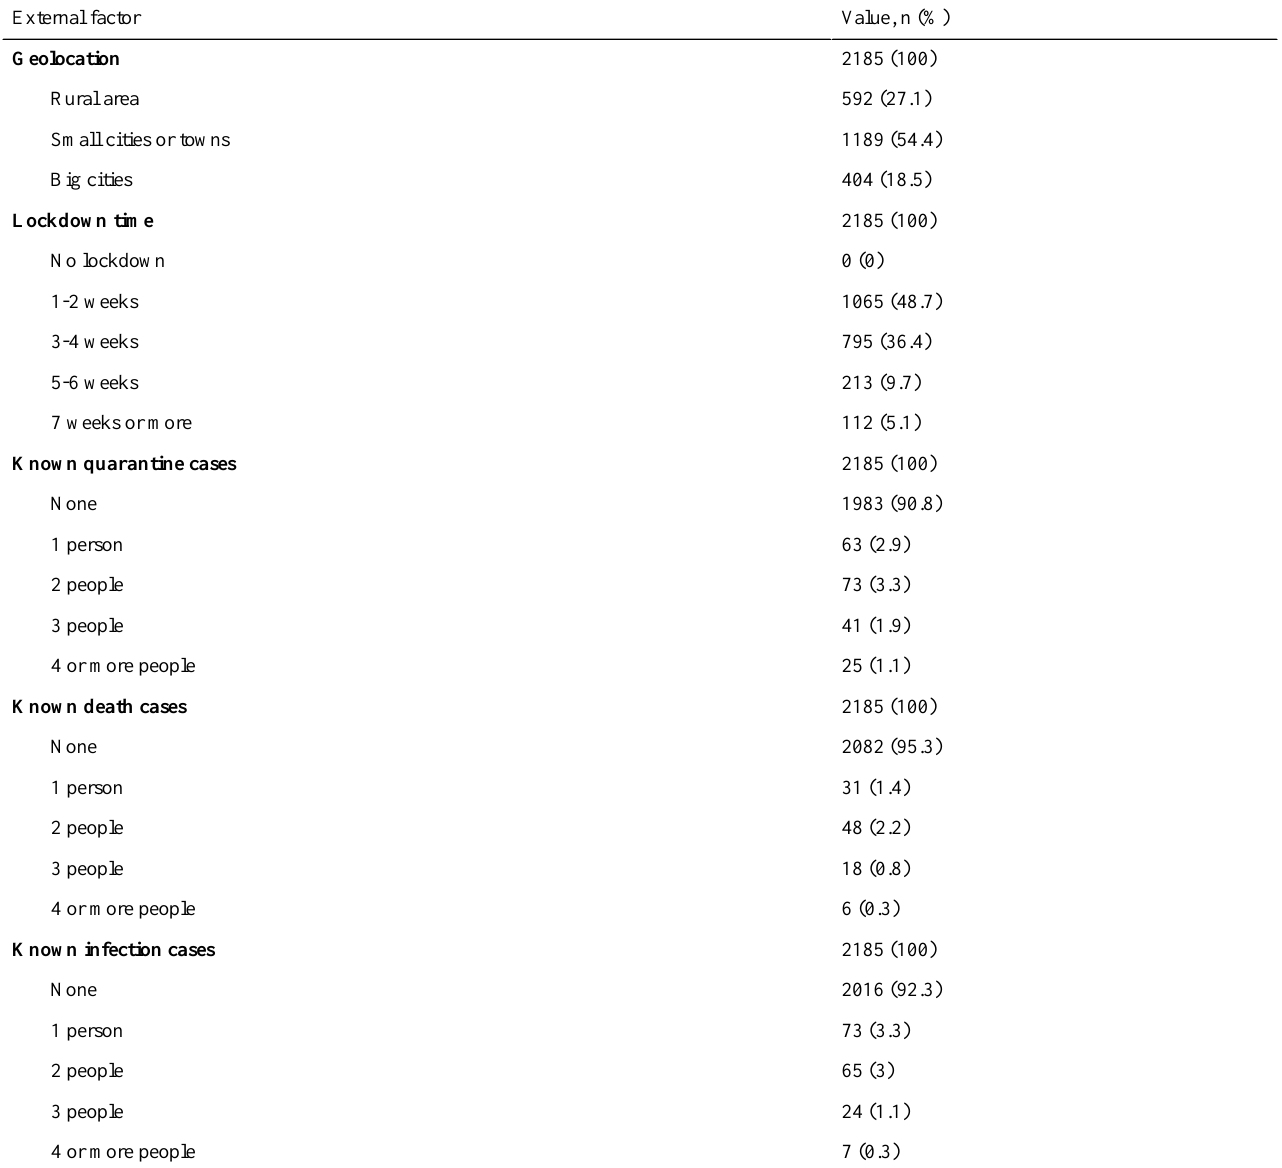
Table 2. External factors contributing to psychiatric disorders